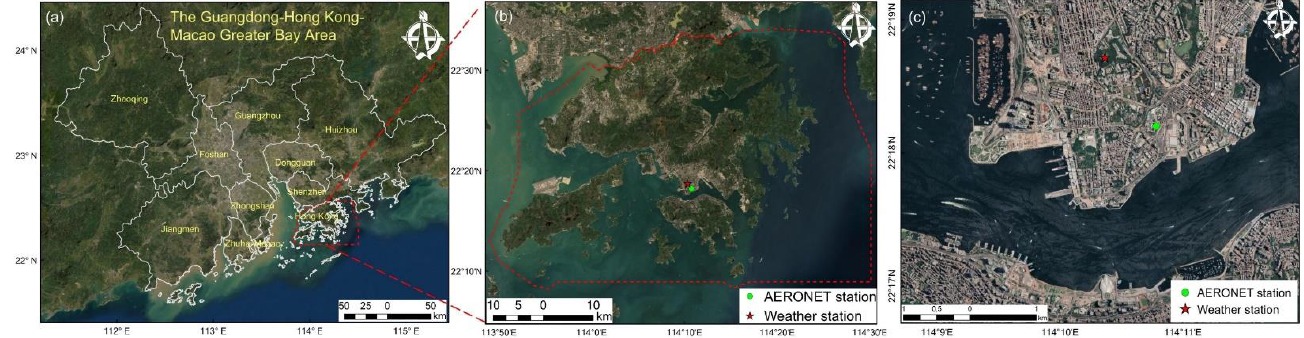
Figure 1. Geographic location of the PolyU AERONET station and King’s Park weather station. ( a ) The Guangdong-Hong Kong-Macao Greater Bay Area, ( b ) Hong Kong, and ( c ) enlarged view of the PolyU AERONET station and King’s Park weather station location.